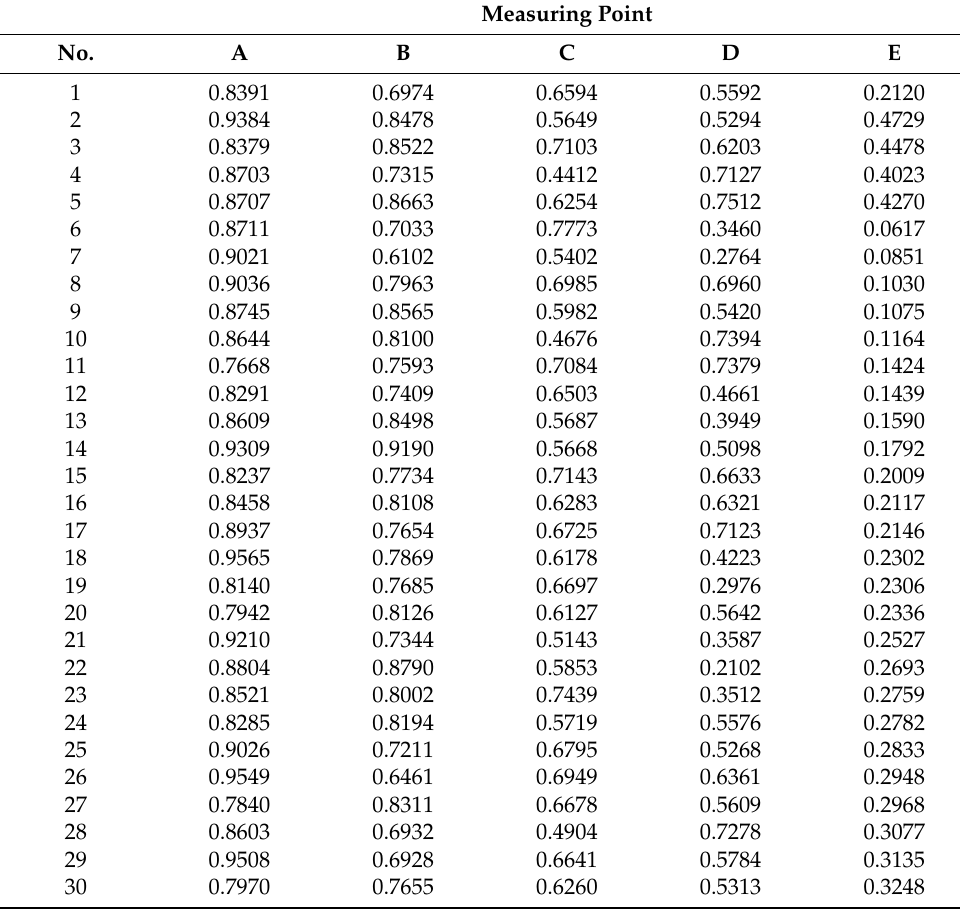
Table A1. The measured values of basic personnel support capacity in the human defense subsystem at different measuring